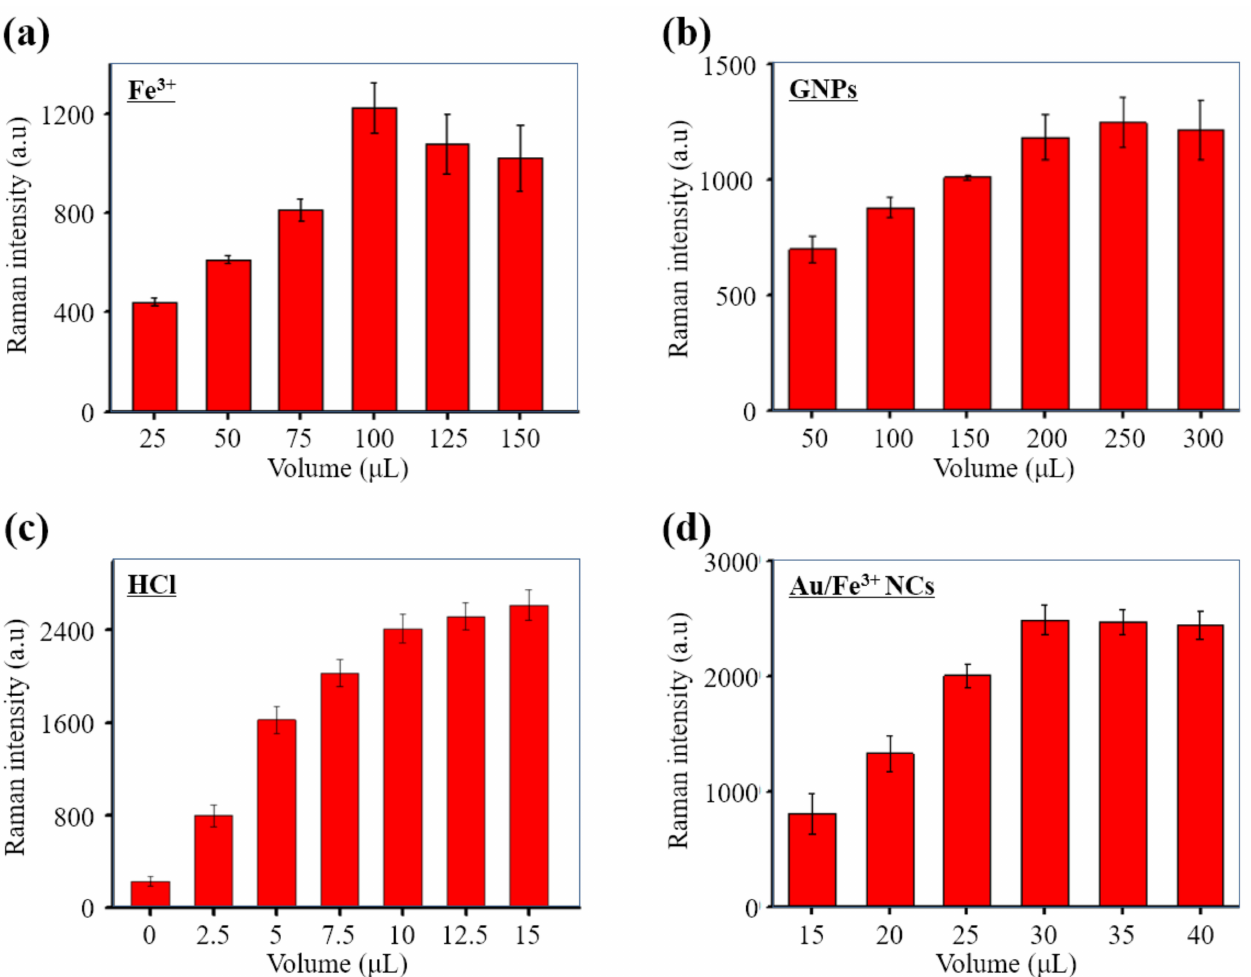
Figure 4. Optimization of the SERS biosensor. Effects of ( a ) Fe 3+ concentration on Au/Fe 3+ NCs, ( b ) Au nanoparticle concentration on Au/Fe 3+ NCs, ( c ) HCl concentration on E. coli O157:H7 detection, and ( d ) the volume of Au/Fe 3+ NCs on E. coli O157:H7